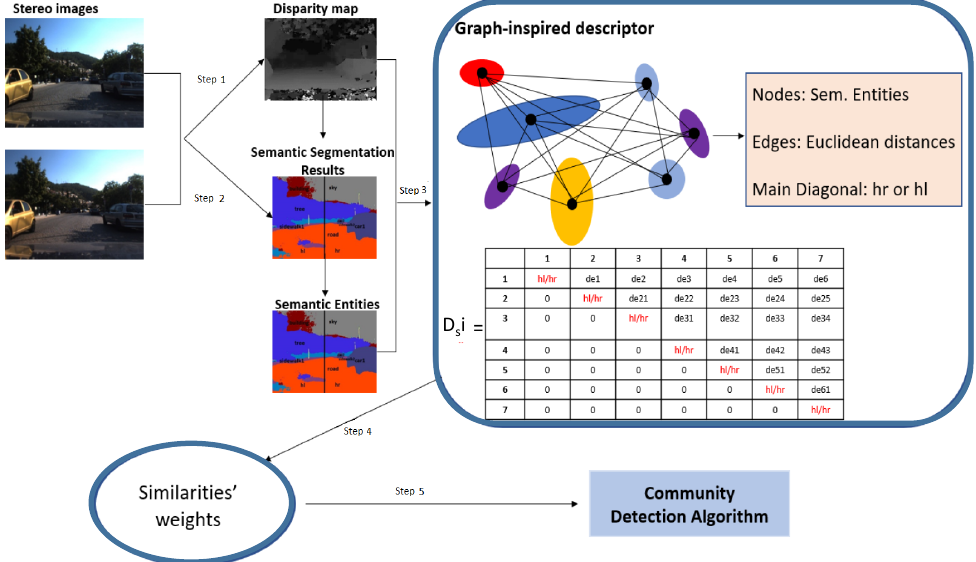
Figure 1. Schematic representation of the procedural steps for the proposed system. Firstly, each input image is semantically segmented, and a disparity map for each stereo image pair is computed. Then, communities are detected by means of graph-based descriptors that include nodes representing the designated entities and edges weighted by the L 2-score between their